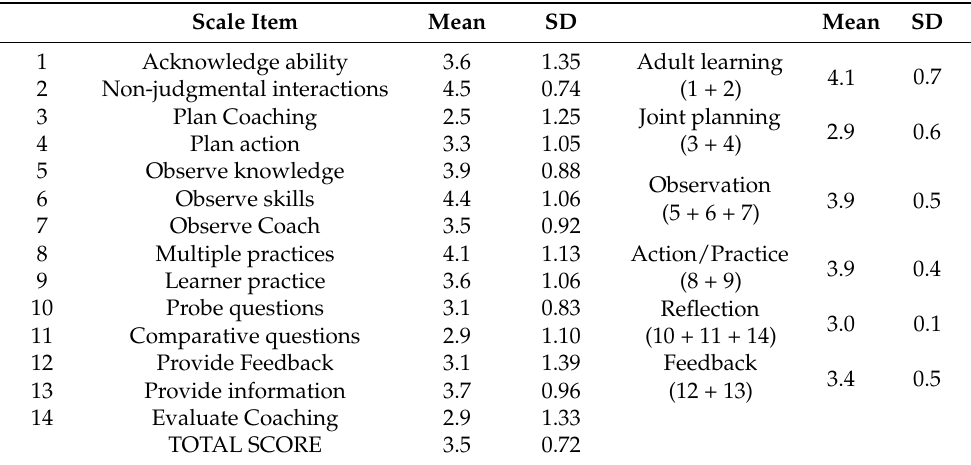
Table 3. Descriptive Statistics Fidelity Coaching